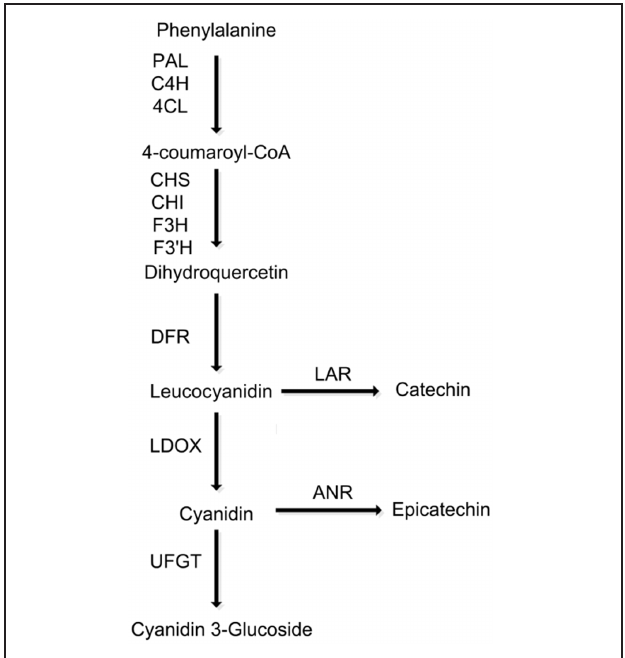
FIGURE 1 | Schematic diagram of the flavonoid biosynthetic pathway in peach. PAL, phenylalanine ammonia-lyase; C4H, cinnamate 4-hydroxylase; 4CL, 4-coumarate:CoA ligase; CHS, chalcone synthase; CHI, chalcone isomerase; F3H, flavanone 3-hydroxylase; F3 (cid:2) H, flavonoid 3 (cid:2) -hydroxylase; DFR, dihydroflavonol reductase; LODX, leucoanthocyanidin dioxygenase; UFGT, UDP glucose, flavonoid 3- O